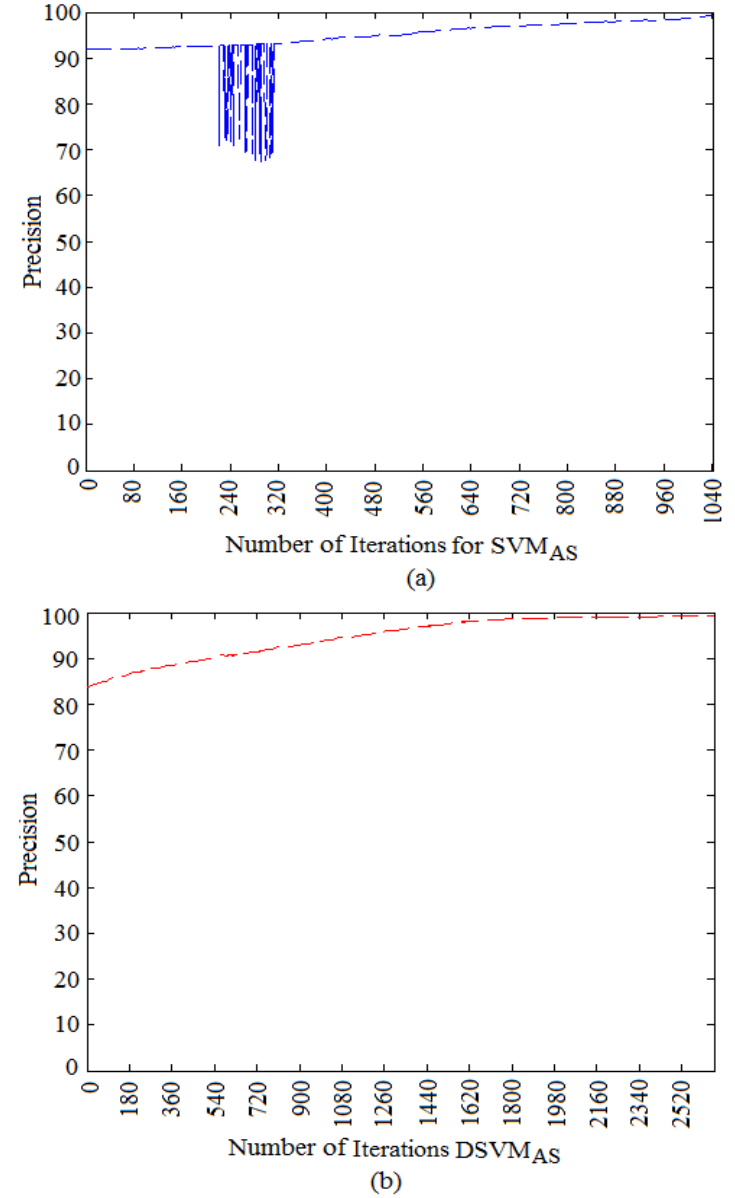
Figure 7. Variation of precision during the iterations of the active learning algorithm: ( a ) SVM AS ( b ) DSVM AS